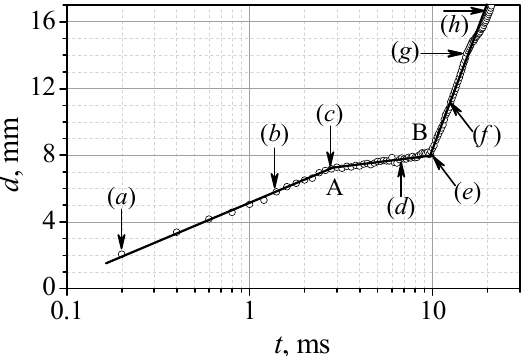
Figure 2. Time dependence of the cavity diameter (Case D1). Dots: experimental data, solid line: approximation. The arrows indicate the instances shown in Figure 3.